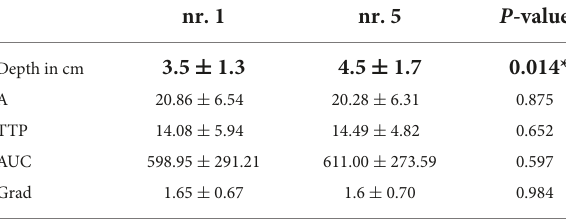
TABLE 5 In ROI 5 , variation of ROIs in depth does not affect TIC parameter values.